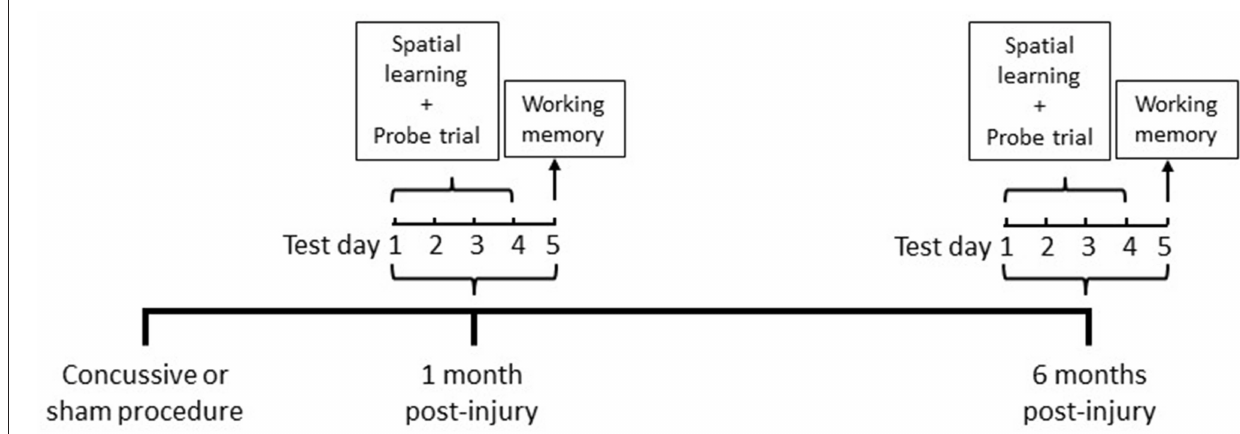
FIGURE 1 | Timeline of MWM chronic cognitive testing paradigm.